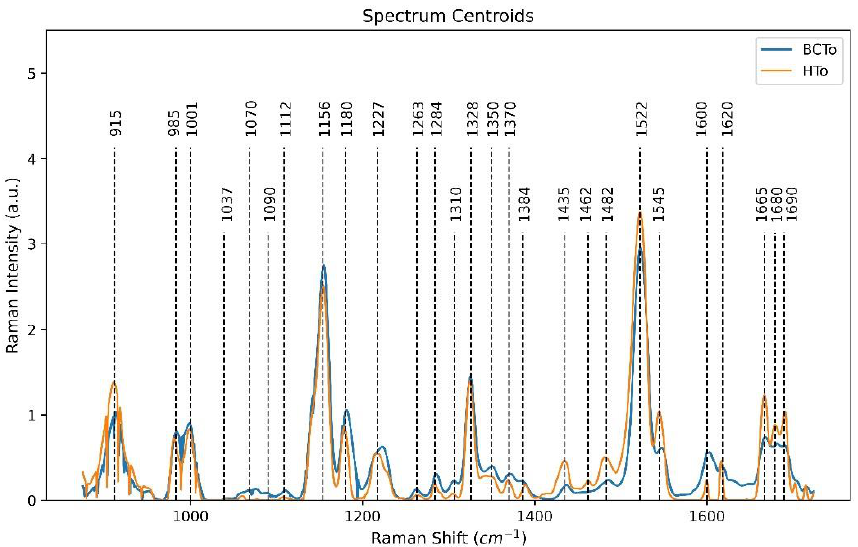
Figure 1. Normalized Raman spectra obtained from healthy tomato plants (HTo) and asymptomatic infected plants (BCTo). Dashed lines represent the wavenumber associated with key compounds.